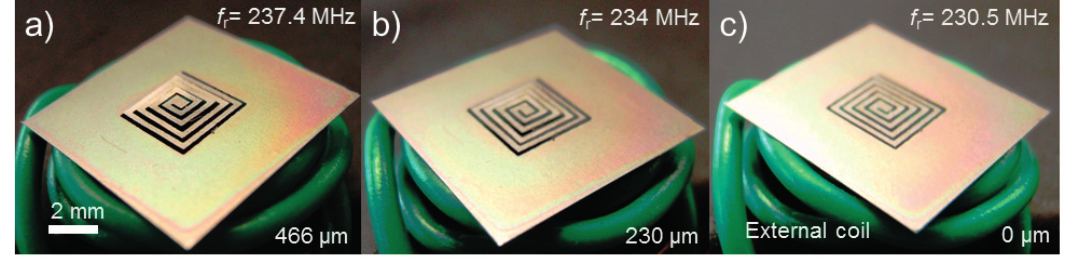
Figure 7. Wireless actuation of a sample device excited with f ( c ) 230 MHz. Each image shows the resultant f actuator at the corresponding